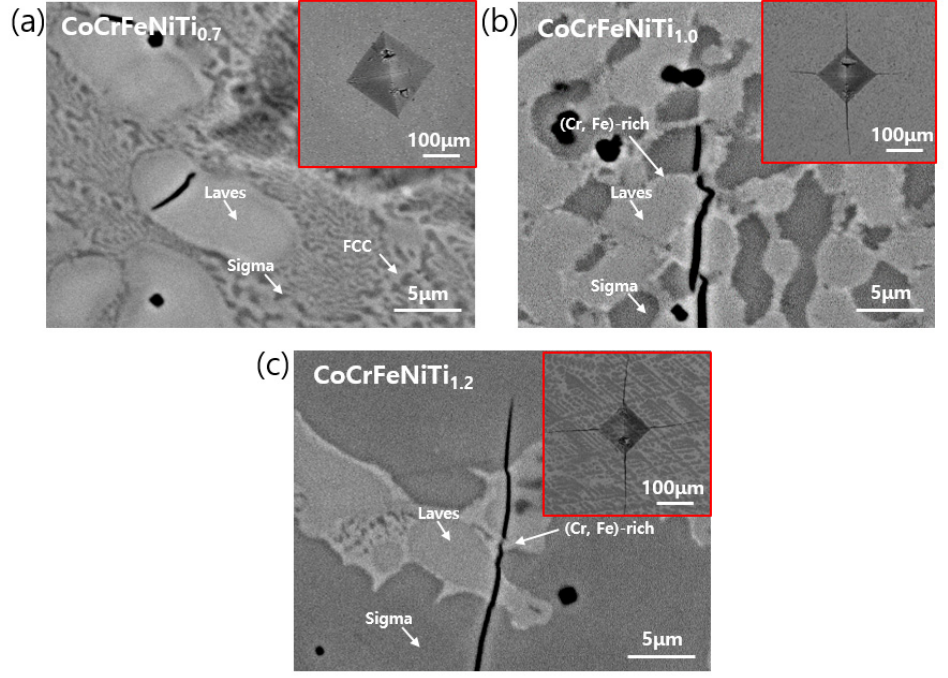
Figure 6. SEM images of toughening mechanisms of CoCrFeNiTix alloys: ( a ) x = 0.7; ( b ) x = 1.0; and ( c ) x = 1.2. The inset images of ( a – c ) show the indentation impression with Palmqvist cracks [21] that emerged from the edge of the indentation diagonals.